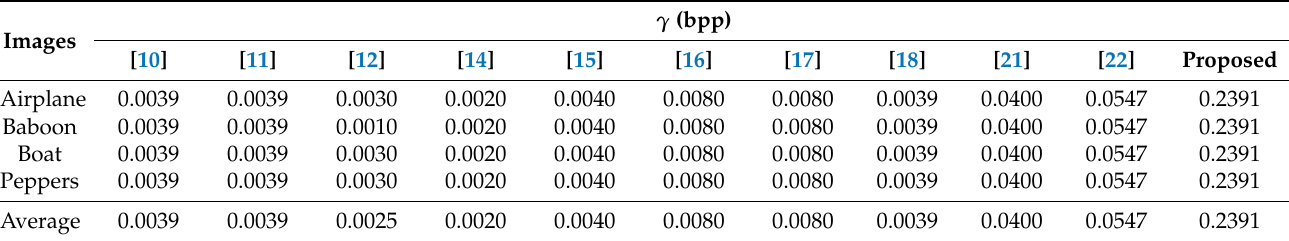
Table 12. Maximum Embedding Rate Comparison in Different